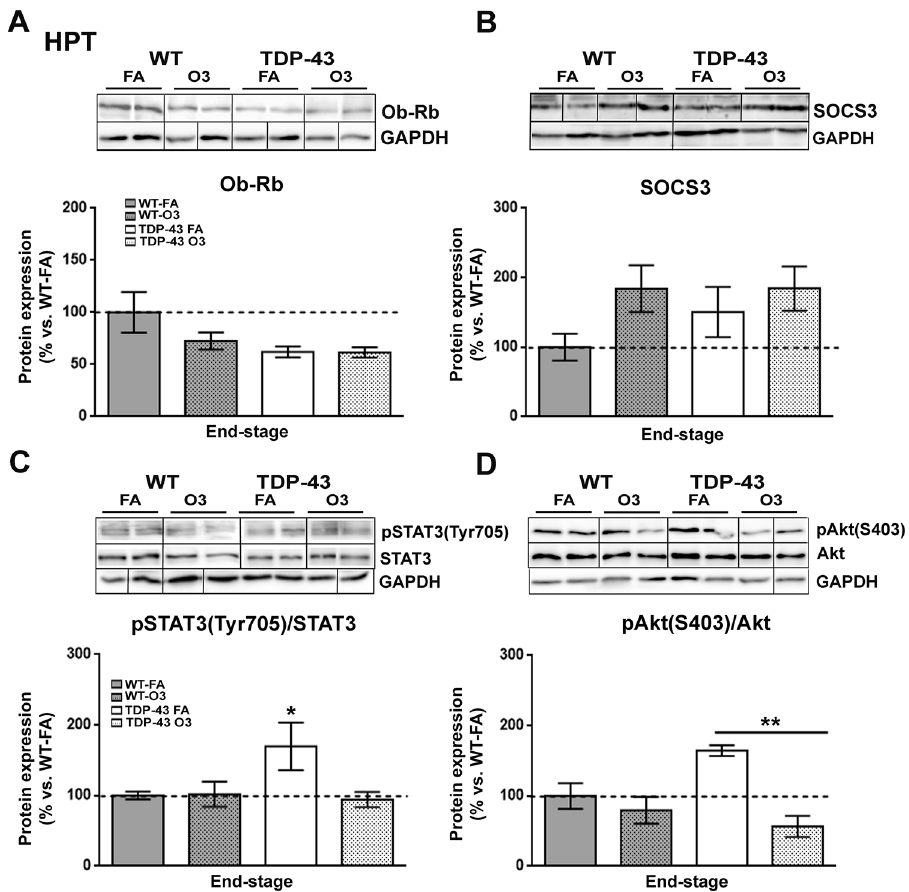
Figure 2. Alterations in serine phosphorylation of Akt in the hypothalamus of TDP-43 A315T mice in response to O 3 exposure. ( A ) Representative β-Actin-normalized immunoblot images and quantitation of Ob-Rb receptor, ( B ) SOCS3, ( C ) pSTAT3 (pTyr705-STAT3) protein, ( D ) pAkt (pSer473-Akt) protein, respectively, in the hypothalamus of TDP-43 A315T mice exposed to FA (n = 3 mice) or O 3 (n = 4 mice) compared to WT controls exposed to FA (n = 5 mice) or O 3 (n = 5 mice) at the end-stage of disease. The white lines in the immunoblot images represent the lanes that were run on the same gel but were non-contiguous. Values are expressed as the mean ± SEM for the different groups. Comparison between groups was performed by two-way ANOVA followed by Dunnett’s post hoc test to compare all groups with WT-FA, while Tukey’s post hoc test was used for multiple comparisons between all groups, where * p < 0.05 vs. WT mice FA-exposed; # p < 0.05 vs. WT mice O 3 -exposed; ** p < 0.05 vs. TDP-43 A315T FA-exposed. In the immunoblot images, representative bands were run on the same gel but were non-continuous. Abbreviations: HPT, hypothalamus; Ob-Rb, long form of leptin receptor; SOCS3, suppressor of cytokine signaling 3; STAT3, signal transducer and activator of transcription 3; Akt , serine/threonine